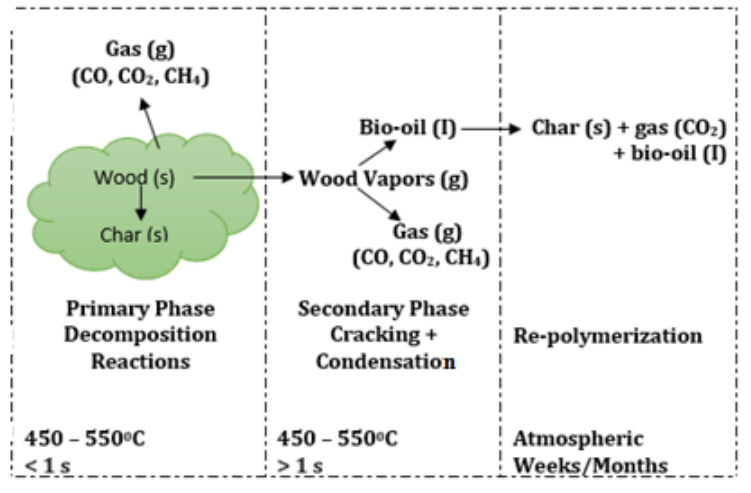
Figure 2. Representation of the reaction paths for wood pyrolysis [41].